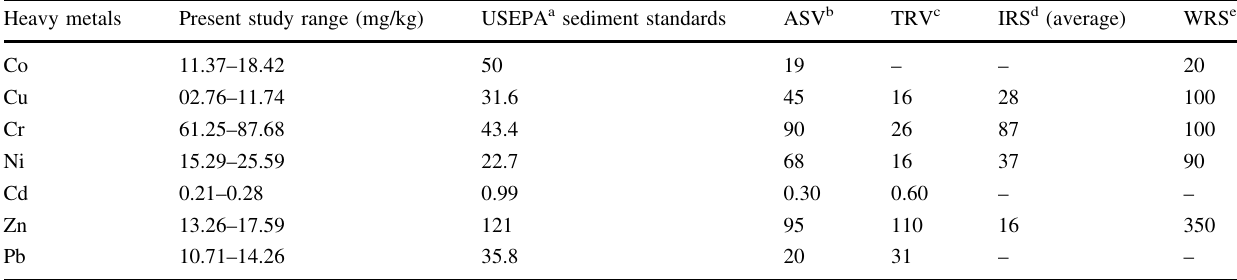
Table 3 Comparative analysis of heavy metal ion concentration of Ghaghara River sediment (GRS) with average shale values (ASV), toxicity reference values (TRV), Indian River system (IRS), and World river system (WRS) Heavy